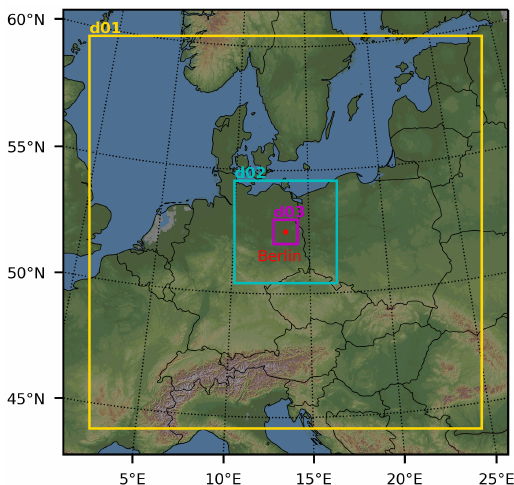
Figure 1. Main domain d01 and nested domains d02 and d03. The elevation is illustrated using the “ASTER Global Digital Elevation Map” from Nasa Worldview [44] as background image.